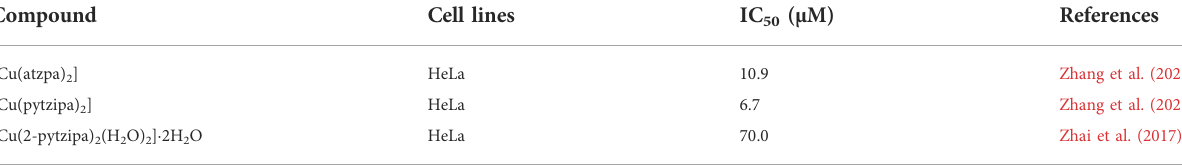
TABLE 3 Comparison of cytotoxicity of Cu(II) compounds based on tetrazole ligands. Compound